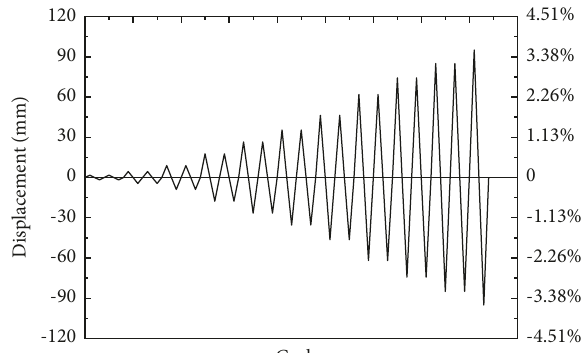
Figure 4: Strain gauge arrangement.